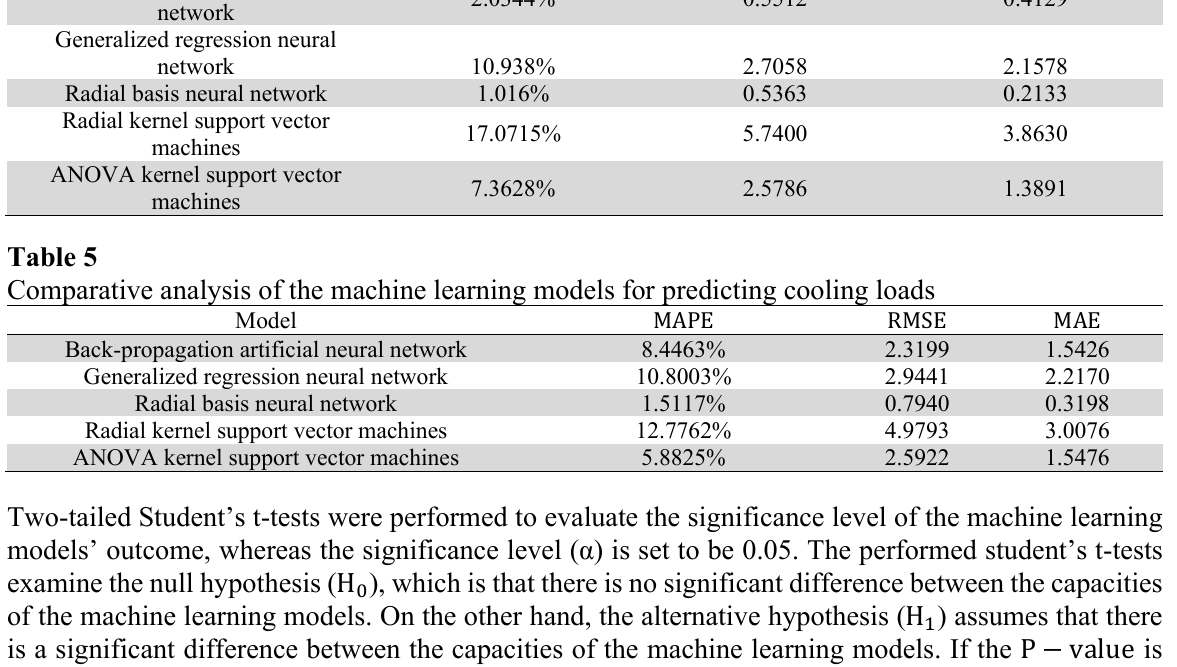
Comparative analysis of the machine learning models for predicting heating loads Model MAPE RMSE MAE Back-propagation artificial neural